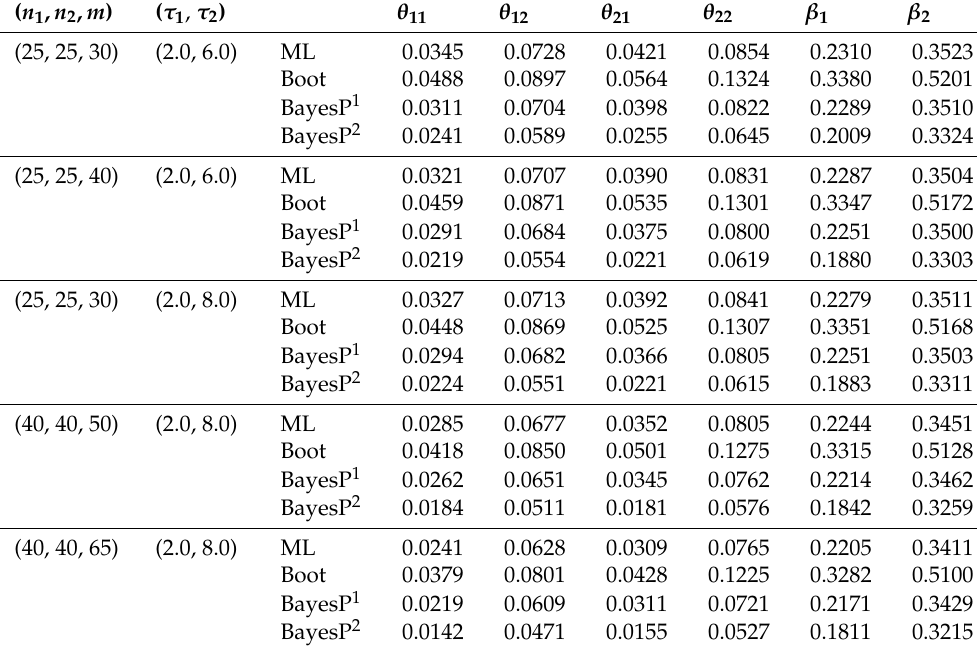
Table 1. MSEs of the parameter estimates for the choose Θ 1 = { 0.05,0.1,0.07,0.12,0.4,0.5 } .